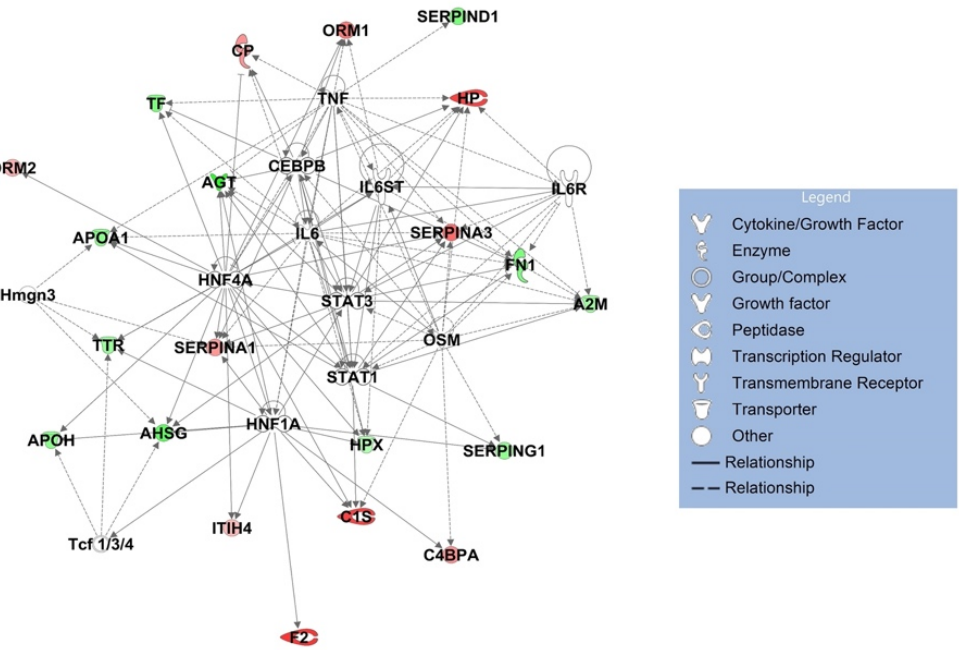
Figure 14. Network of 12 most statistically significantly altered upstream regulators (acute-phase response signaling). response signaling).